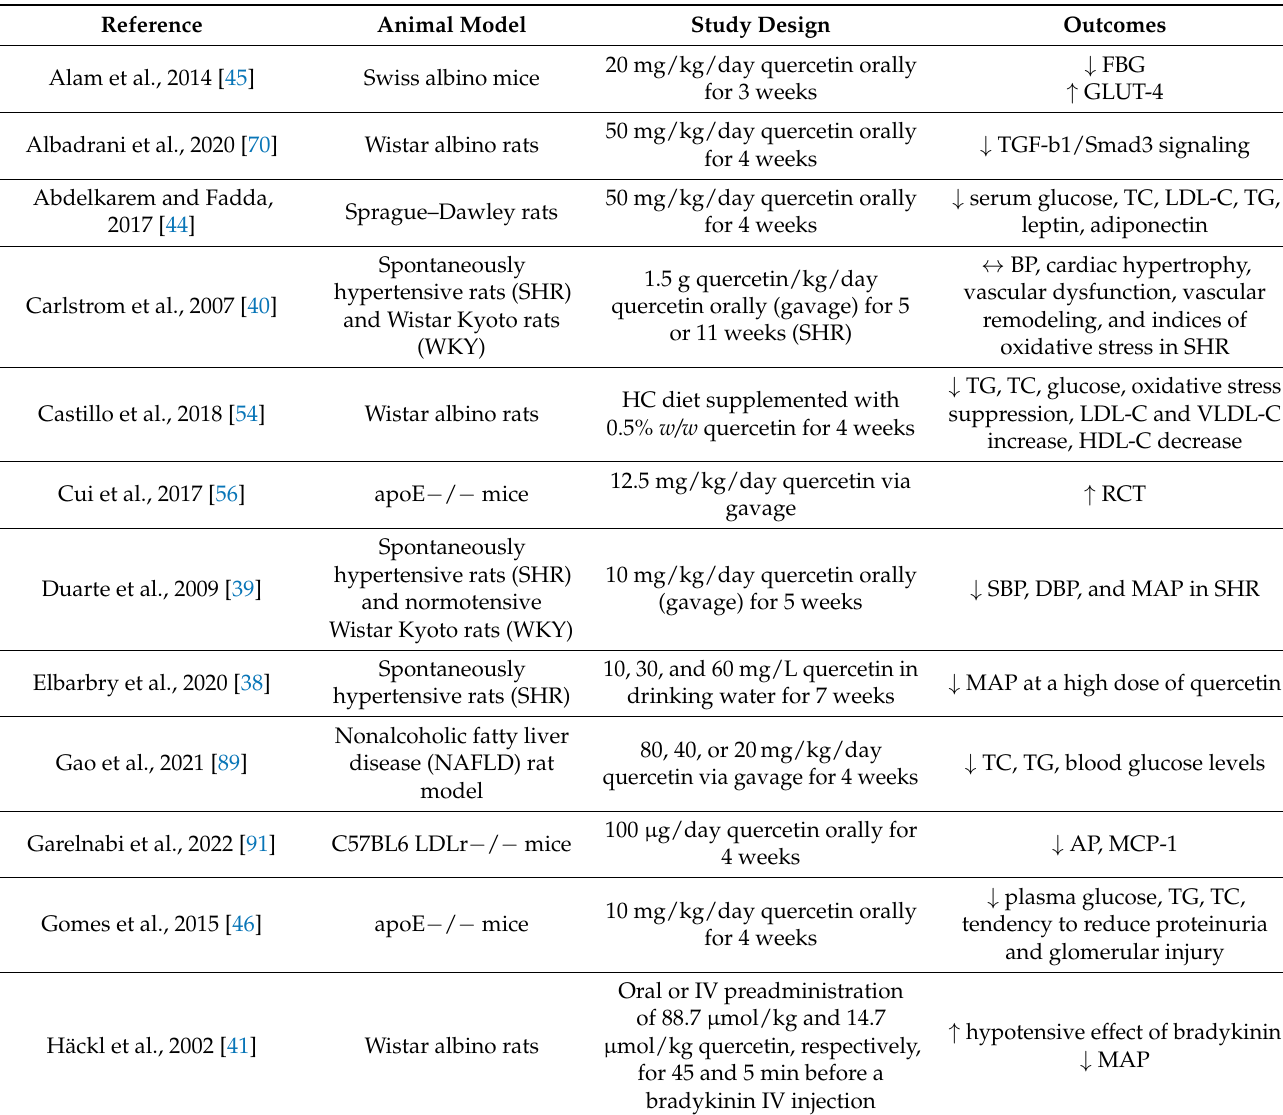
Table 1. Published preclinical studies investigating the impact of quercetin on classical cardiovascular risk